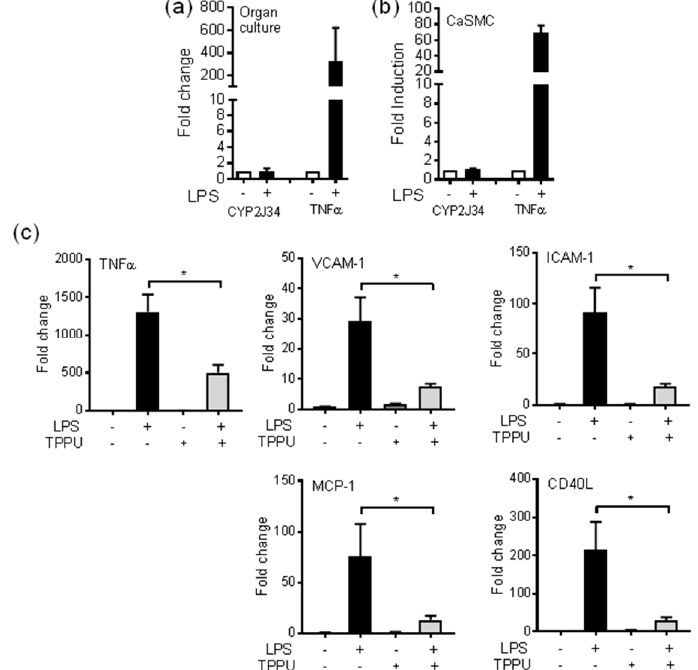
Figure 5. The sEH inhibitor TPPU is anti-inflammatory in coronary artery vascular smooth muscle cells. Expression of TNF α and CYP2J34 mRNA in ( a ) combined pig coronary and pulmonary artery vessels in organ culture at 24 h ( n = 4), and ( b ) pig primary coronary artery cells at 4 h (CaSMCs) in the presence or absence of LPS (1 μ g/mL). mRNA was measured by qRT-PCR and fold levels normalized to 18S. ( c ) Inflammatory target gene expression of TNF α , VCAM-1, ICAM-1, MCP-1 ( CCL2 ) and CD40 in cultures of pCASMCs in the presence or absence LPS (1 μ g/mL; 4 h), and/or sEH inhibitor TPPU (1 μ M; given as a 1 h pretreatment before addition of LPS). * indicates p < 0.05 by paired t -test between cells treated with TPPU in the presence of absence of LPS. Data represents mean ± SE from n = 4 cultures from two separate animals.